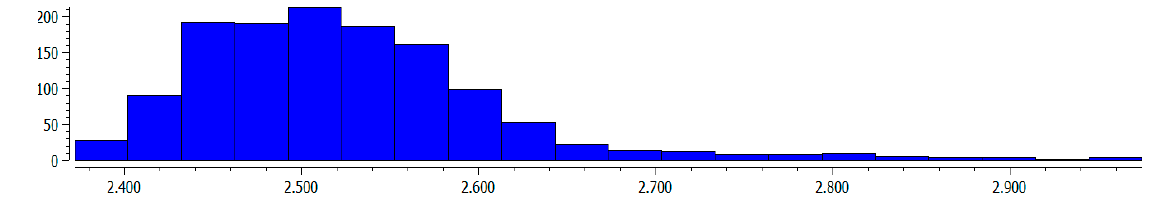
Figure 1. The histogram of O ∙∙∙ O distances (Å), the vertical axis shows the number of entries.